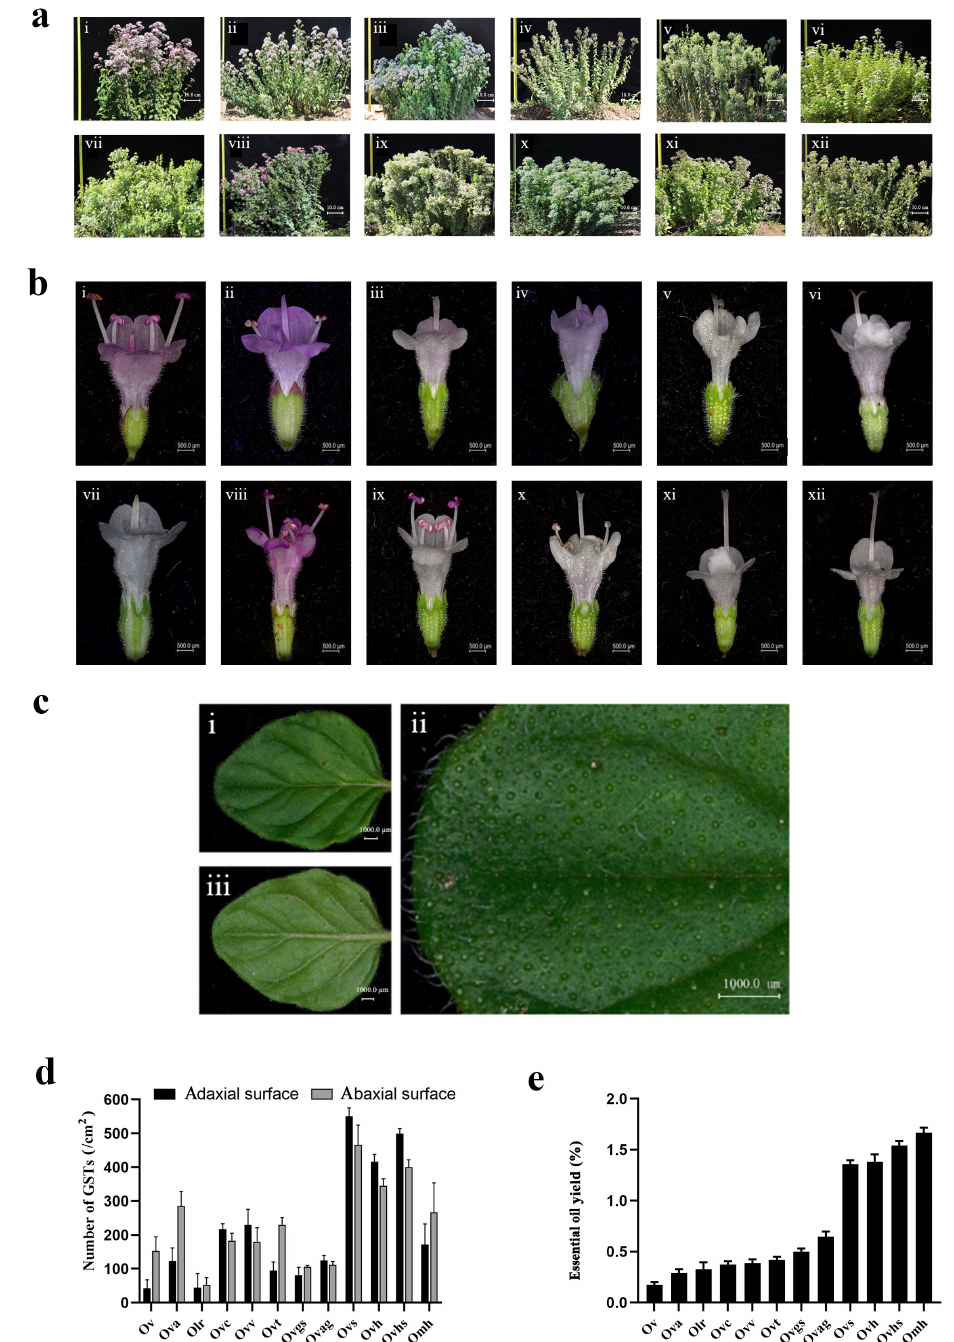
Figure 1. Phenotypic evaluation of one wild Chinese and eleven European oregano ( Origanum ) accessions. ( a ) Plant type. ( i ) O. vulgare (Ov); ( ii ) O. vulgare ‘Creticum’ (Ovc); ( iii ) O. vulgare ‘Golden Shine’ (Ovgs); ( iv ) O. × majorana ‘Hippokrates’ (Omh); ( v ) O. vulgare ‘Hot & Spicy’ (Ovhs); ( vi ) O. vulgare ‘Aurea’ (Ova); ( vii ) O. vulgare ‘Aureum Gold’ (Ovag); ( viii ) O. laevigatum ‘Rosenkuppel’ (Olr); ( ix ) O. vulgare ‘Samothrakb’ (Ovs); ( x ) O. vulgare subsp. hirtum (Ovh); ( xi ) O. vulgare ‘Thumble’s variety’ (Ovt); ( xii ) O. vulgare ‘Varona’ (Ovv). ( b ) Floral organ arrangement. Labels ( i – xii ) are the same as described in ( a ). Scale bars = 500.0 µ m. ( c ) Glandular secretory trichomes (GSTs) on the adaxial surface ( i ) and abaxial surface ( ii , iii ) of leaves. Scale bars = 1000.0 µ m. ( d , e ) GST density on the adaxial and abaxial surfaces of leaves ( d ) and essential oil yield ( e ) of 12 oregano